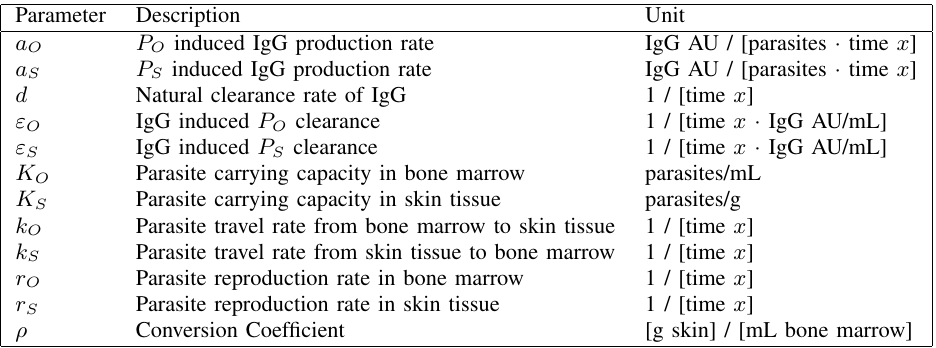
TABLE I: Parameters for the within-host